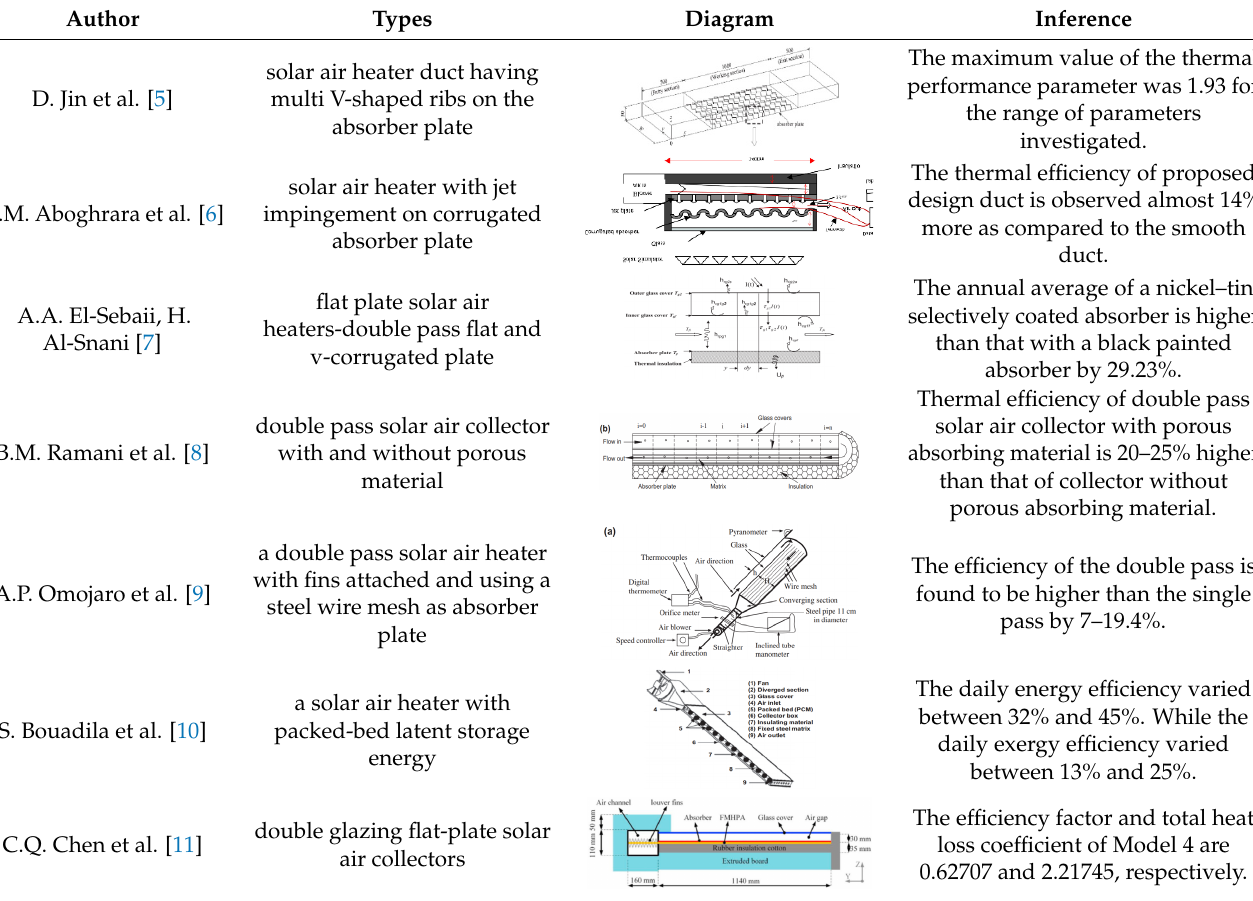
Table 1. Investigations on thermal performance of different types of solar air collectors.